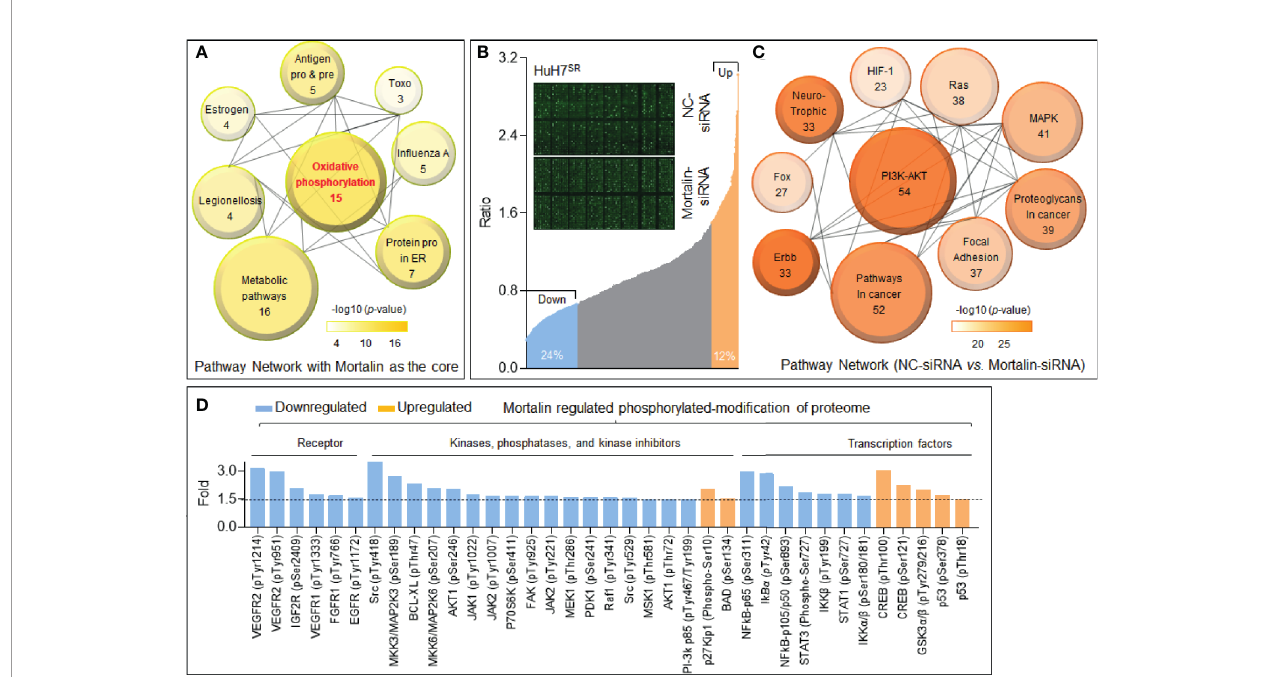
FIGURE 2 | Mortalin regulates the phosphorylation of cancer-associated proteins in hepatocellular carcinoma (HCC) cells. (A) Kyoto Encyclopedia of Genes and Genomes (KEGG) pathway enrichment analyses of the 20 most frequently altered neighbor interactors and 30 indirect interactors with mortalin from STRING database (Search Tool for the Retrieval of Interacting Genes). The size of the circle indicates the number of genes enriched in the item, and different color shades indicate the size of p-value. (B) Phospho-antibody microarray analysis of the changes in expression of phosphoproteins following mortalin knockdown in HuH7 SR cells. Upregulation of phosphorylation by more than 50% (1.5-fold) is shown in orange, and downregulation of more than 33% (1.5-fold) is shown in blue. (C) KEGG pathway enrichment analyses of the proteins with upregulation or downregulation of phosphorylation of more than 1.5-fold upon mortalin knockdown; the top 10 pathways are shown. (D) Phospho-antibody microarray data showing the phosphorylation levels of critical receptors, kinases, phosphatases, kinase inhibitors, and transcription factors that are involved in the top 5 pathways listed in panel (C) The data presented for each phosphorylation site are the mean of two biological